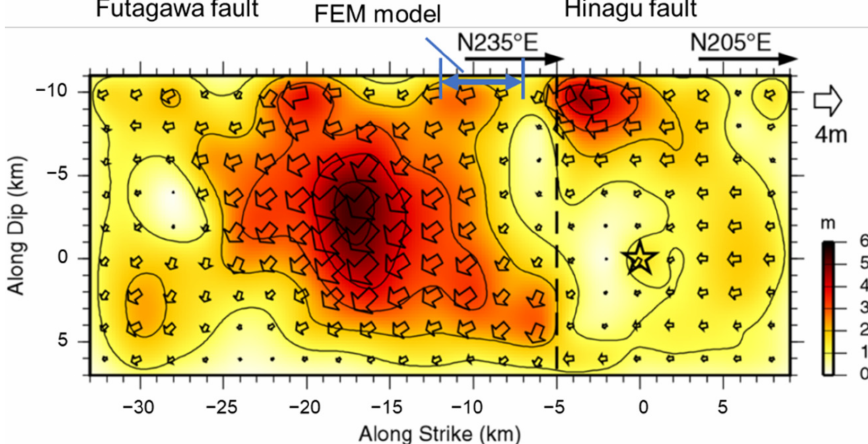
Figure 6. Slip distribution on main faults (modified, Asano and Iwata